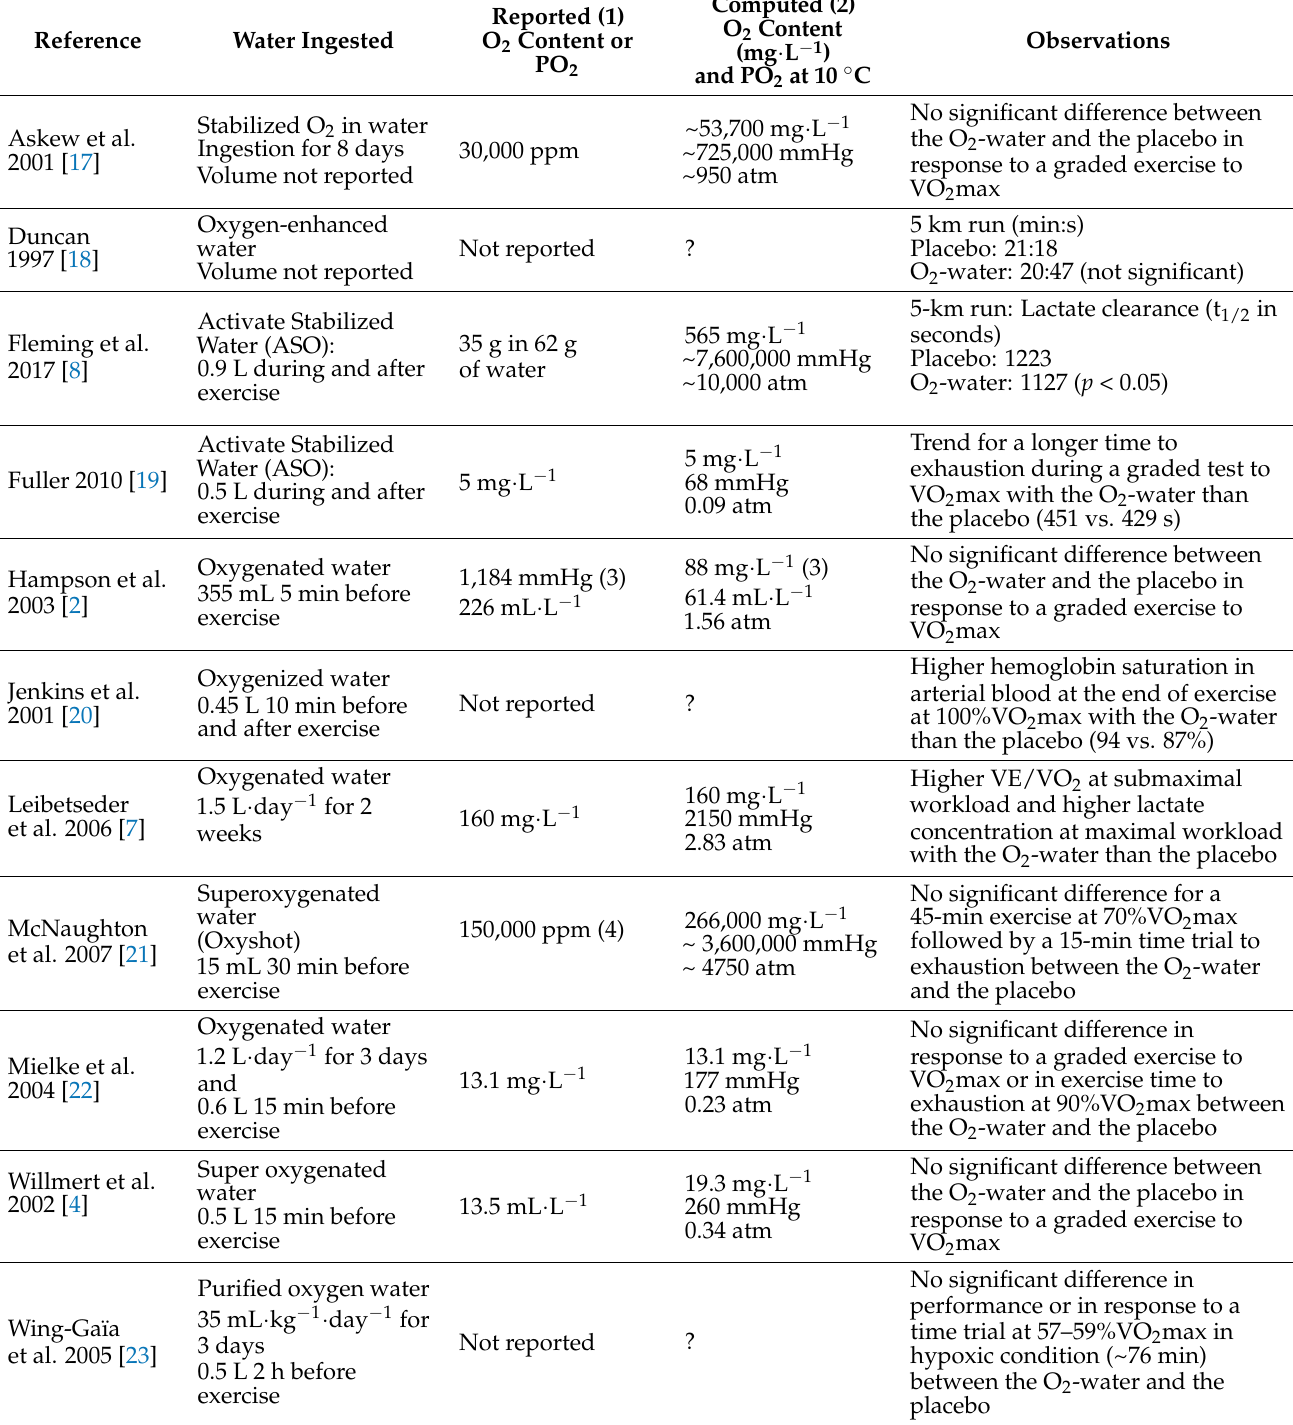
Table 1. Studies of the effects of O 2 -water ingestion on performance and on the response to exercise.